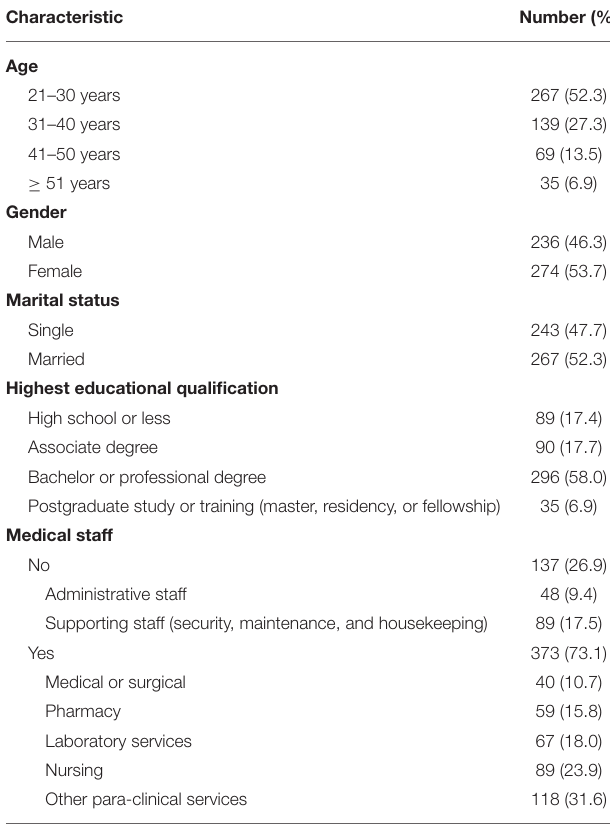
TABLE 1 | Characteristics of the participants.